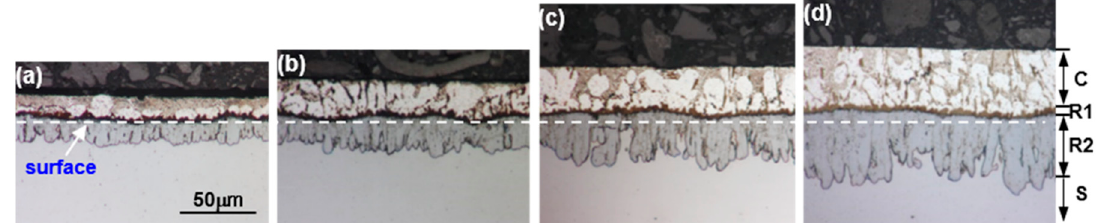
Figure 1. Cross-sectional optical micrographs of specimens that were hot dipped at 690 °C for durations, ( a ):30, ( b ): 60, ( c ): 120, ( d ):180 s.